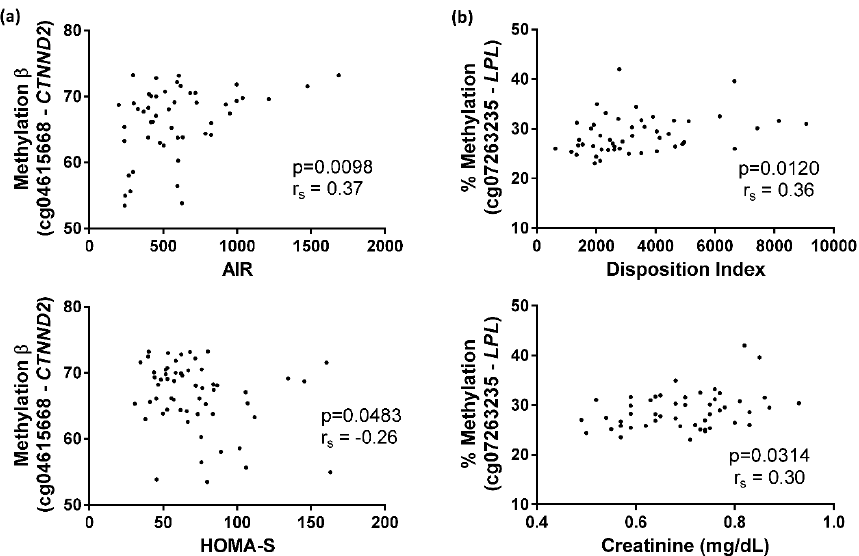
Figure 6. Spearman correlations of cg04615668 and cg07263235 methylation. ( a ) Correlation between cg04615668- CTNND2 methylation and acute insulin response (AIR) index or homeostasis model assessment insulin-sensitivity (HOMA-S) index; ( b ) Correlation between cg07263235- LPL methylation and disposition index (DI) or plasma